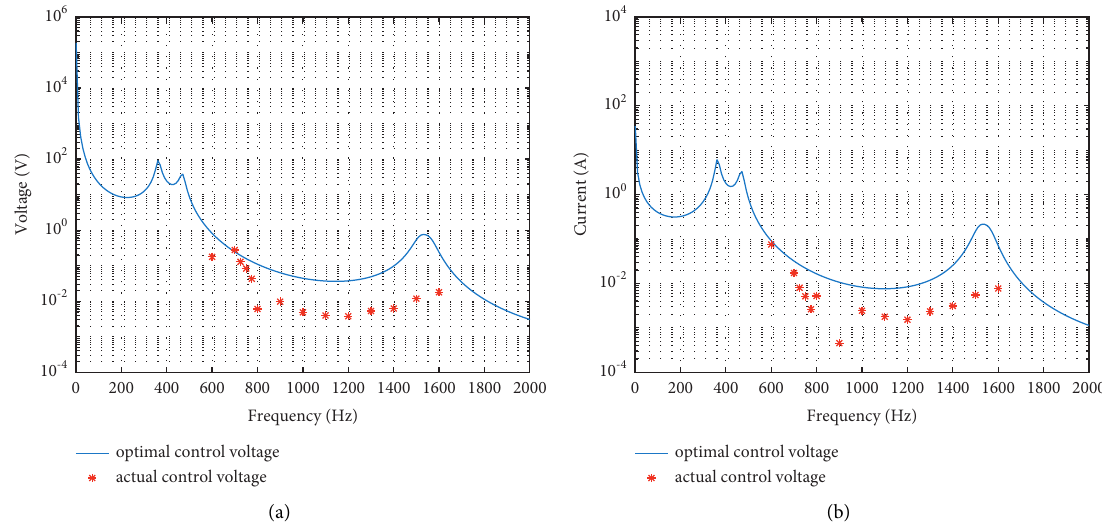
Figure 29: Driving voltage and current at different operating frequencies. (a) Driving voltage. (b) Driving